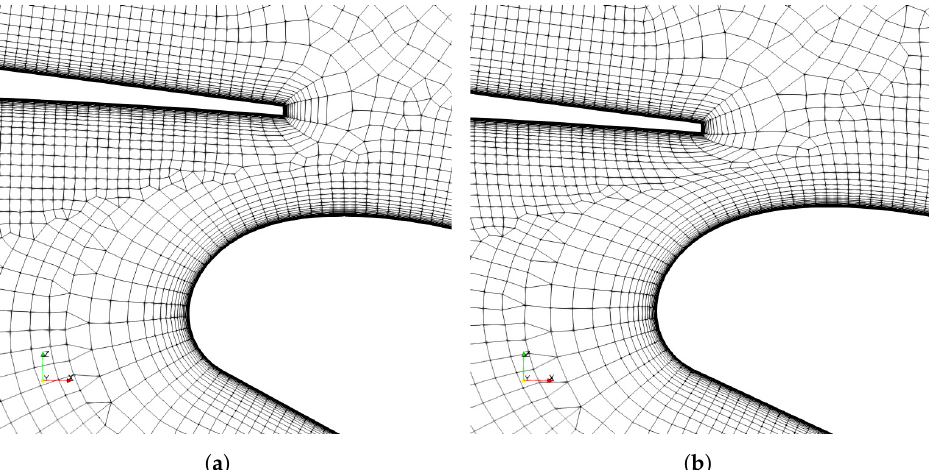
Figure 3. Mesh deformation due to the movement of flap for a three-element aerofoil. ( a ) Initial mesh. ( b ) Deformed